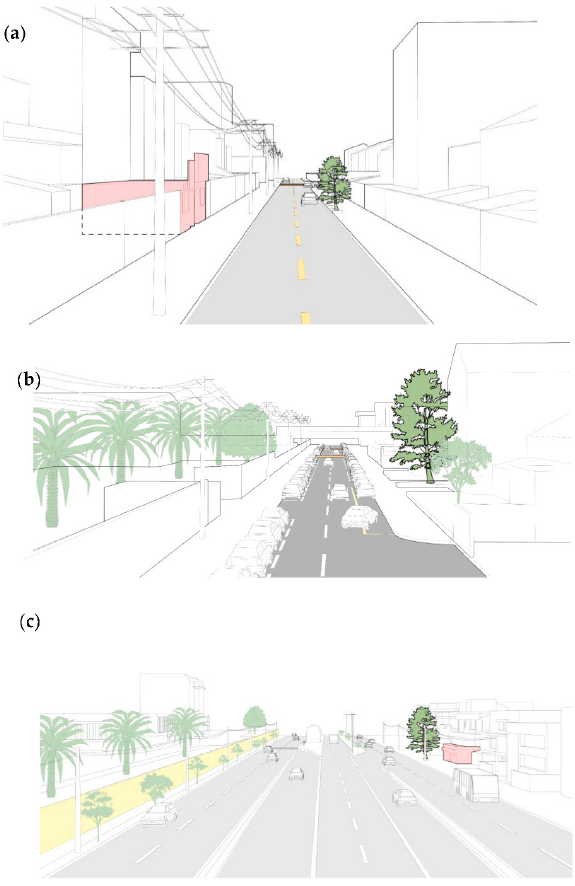
Figure 2. Visual description of: ( a ) a shallow canyon street (Point S19); ( b ) a wide road (Point S7); ( c ) and open road (Point S14), with mobile (cars) and stationary sources (restaurants, in red), and sampled trees bordered in black.